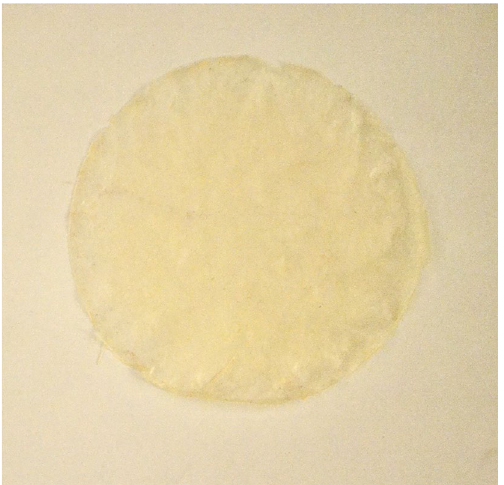
Figure 1. The cellulose nanocomposite film containing nano clay is used for saffron